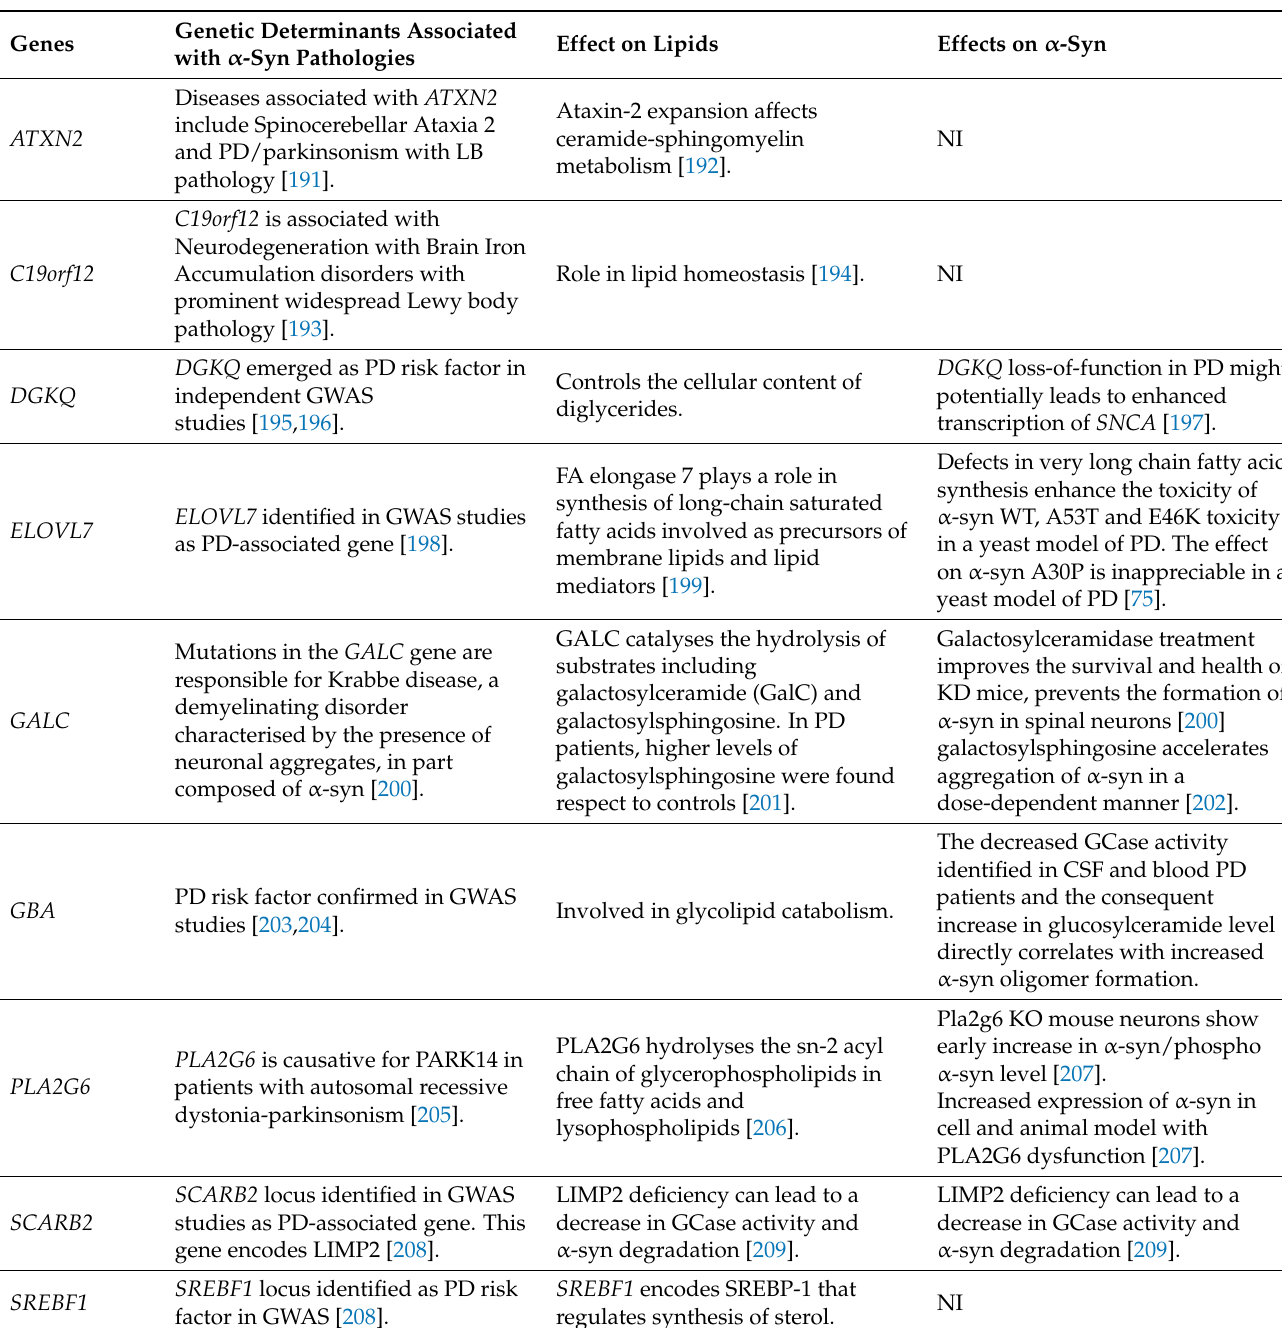
Table 5. Presentation of some genetic determinants associated with α -synuclein ( α -syn) pathology and having a direct relationship with lipid pathways. This table provides some examples of different genes (first column) associated with α -syn pathology and/or to parkinsonism (second column). Mutations in these genes can directly affect the biological metabolism (third column) and, in some cases, the properties of α -syn (fourth